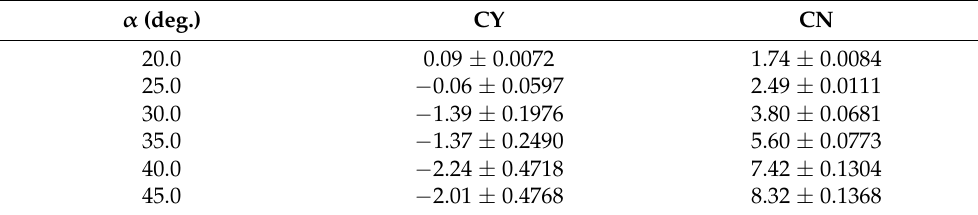
Table 4. Side and normal force coefficients versus angle of attack: Ma = 0.2, Re = 2 × 10 6 . Grid U2. α